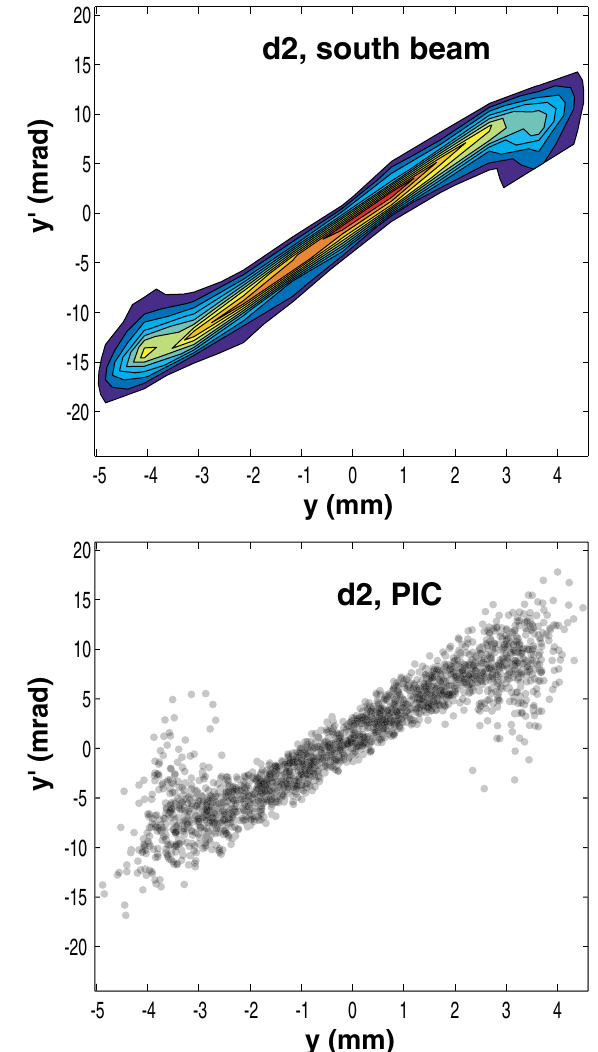
FIG. 4. (Color) Measured transverse phase space at d 2 of one beam compared to the result from PIC simulations. The contour lines indicate 10% increments in relative intensity, and the color code sequence from lowest to highest intensity is blue, . . . , red.